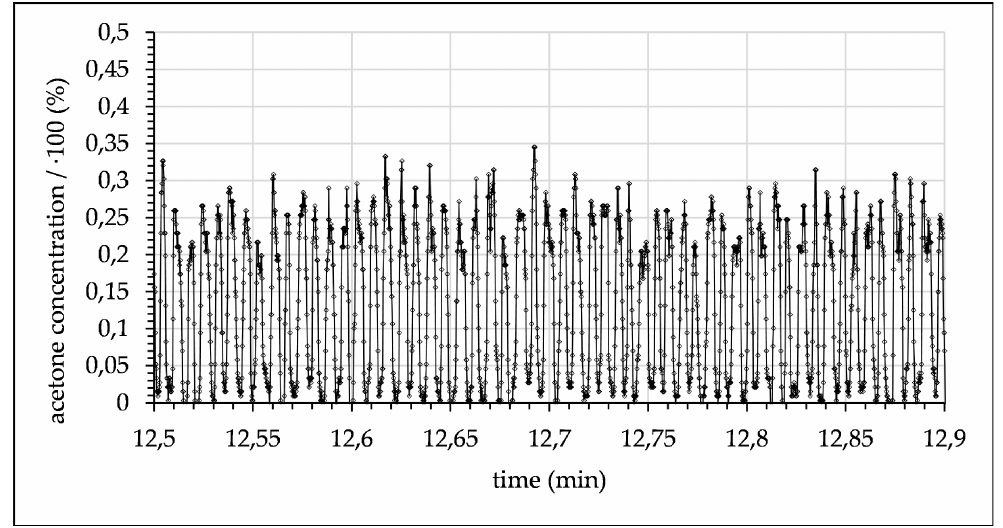
Figure 8. Measured acetone concentration in toluene droplets alternating with water droplets (flow rate 0.1 mL/min with 1.5 s time delay after contact of toluene and water).